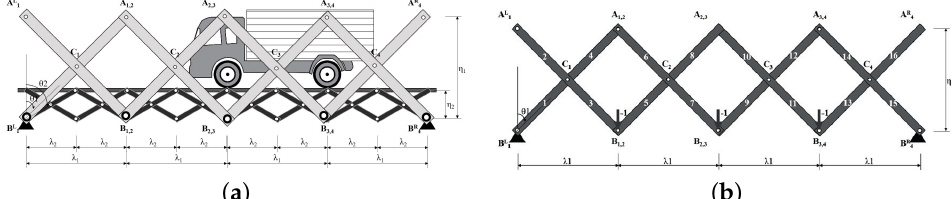
Figure 10. The load P = 1 distributes to the CSCI and the truck loading on the CSCI. ( a ) The truck loading on the CSCI. ( b ) The unit load transferring to the main SCI.